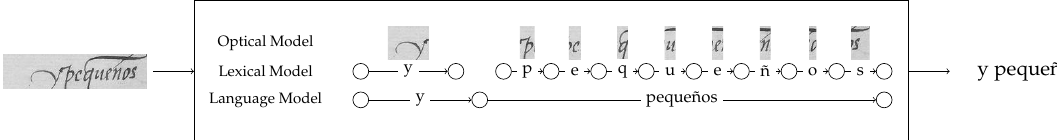
Figure 2. Scheme of a handwritten text recognition